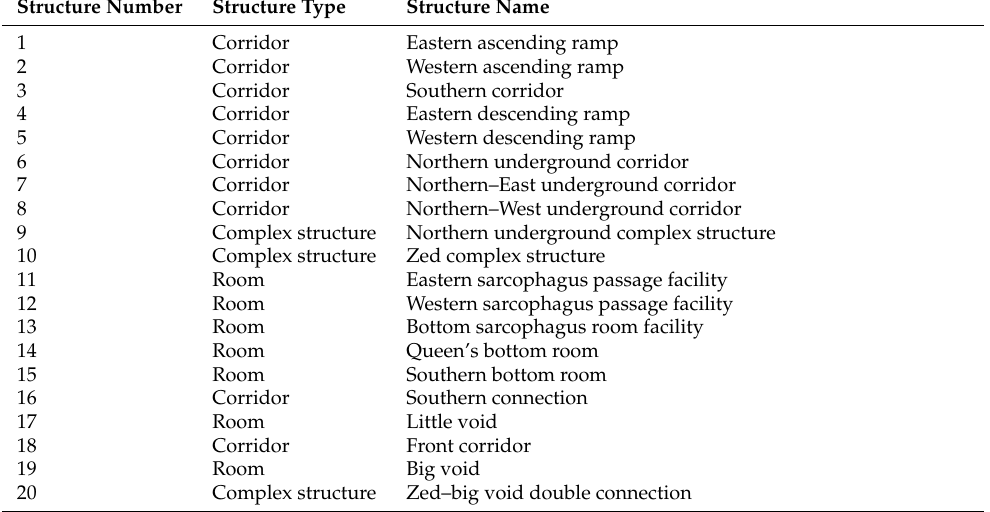
Table 3. List of discovered